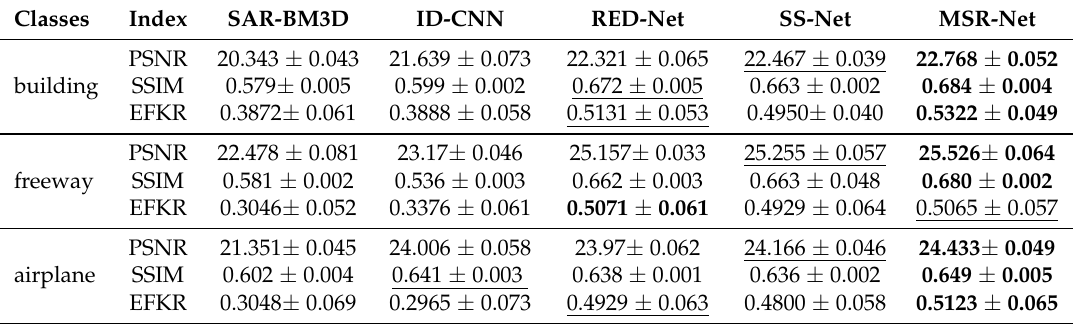
Table 1. The peak signal to noise ratio (PSNR), structural similarity (SSIM), and edge feature keep ratio (EFKR) of test set with noise level L = 2.